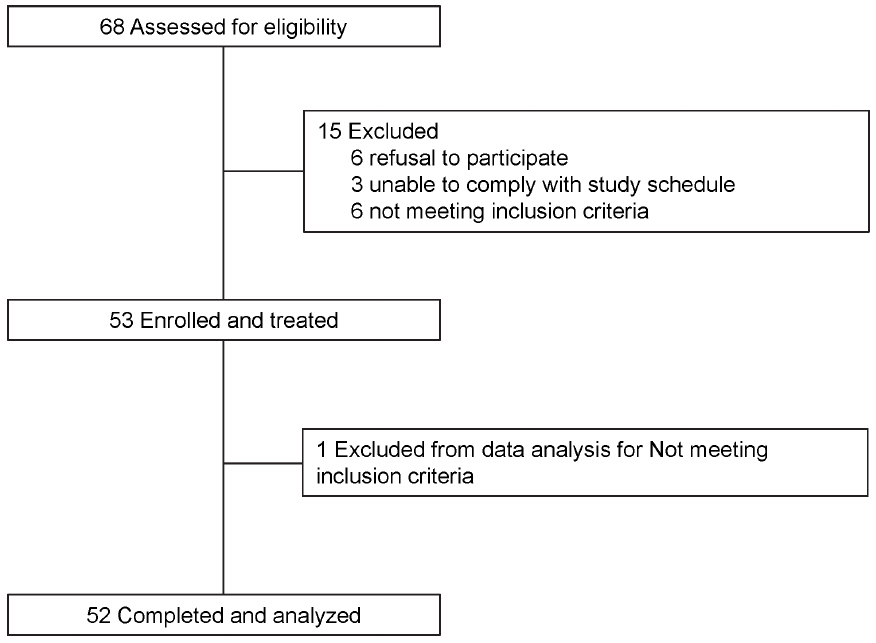
Figure 1. Study flow diagram.